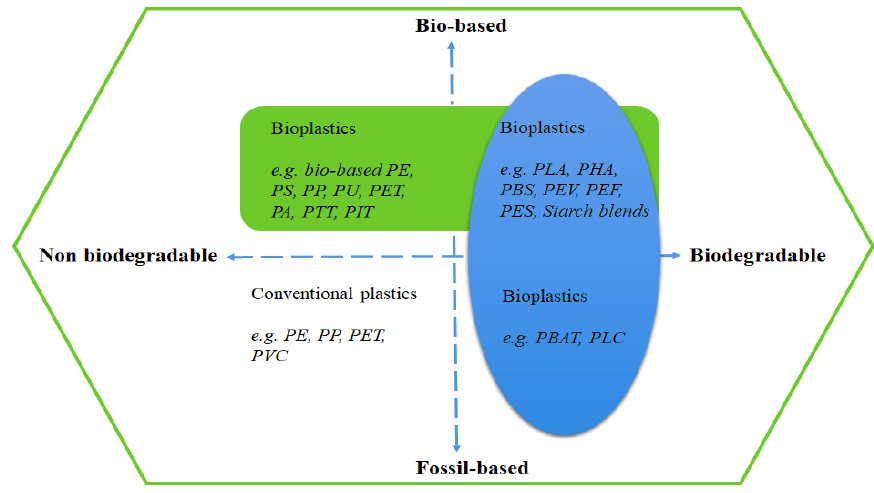
Figure 1. Schematic illustration of the differentiation and definition of biodegradable plastics.